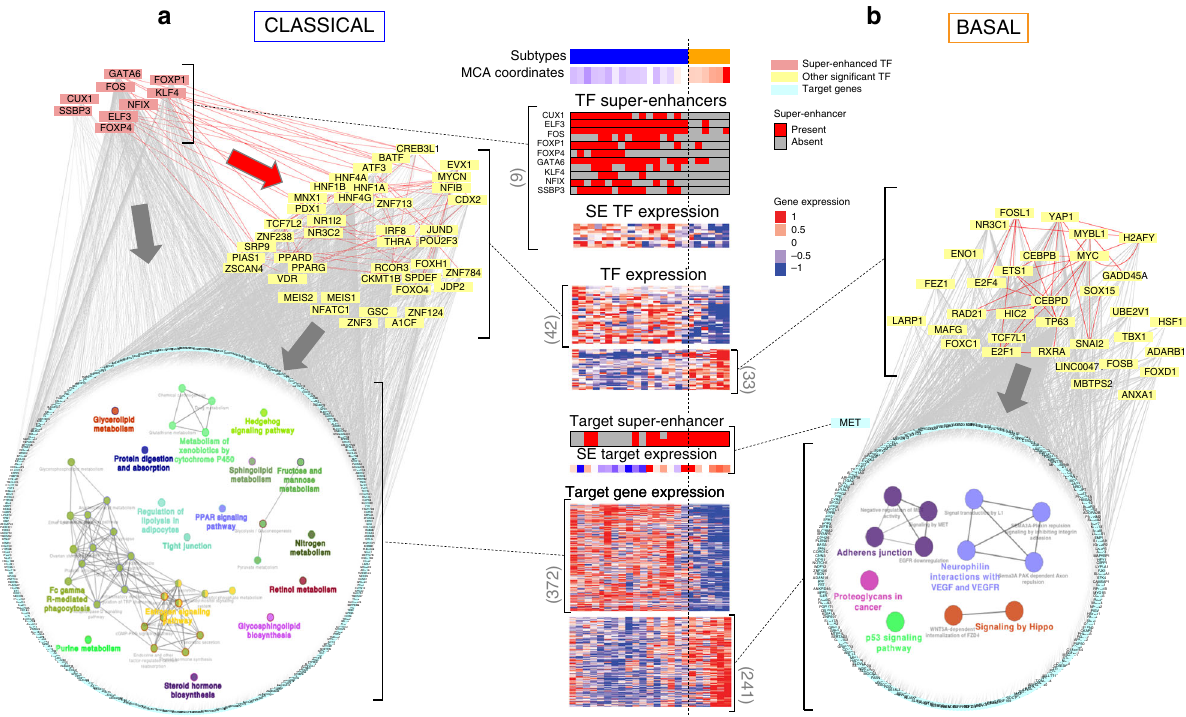
Fig. 4 Transcriptional regulatory networks for PDAC phenotypes. TFs found to be signi fi cant regulators of the a classical- and b basal-associated genes were used to reconstruct regulatory networks. Networks include TFs upregulated by super-enhancers (upper-left light red nodes in a only), signi fi cant TFs (yellow), and their targets arranged in a circular layout. In each circle, cellular pathways and functions over-represented among the target genes of each network (classical a , basal b ) are shown and grouped by gene-set similarity. In the center of a and b , the heatmaps of TF expression and their targets, as well as the heatmaps of super-enhancers are represented. Red arrow corresponds to TF – TF regulation, and gray arrows to TF – nonTF target